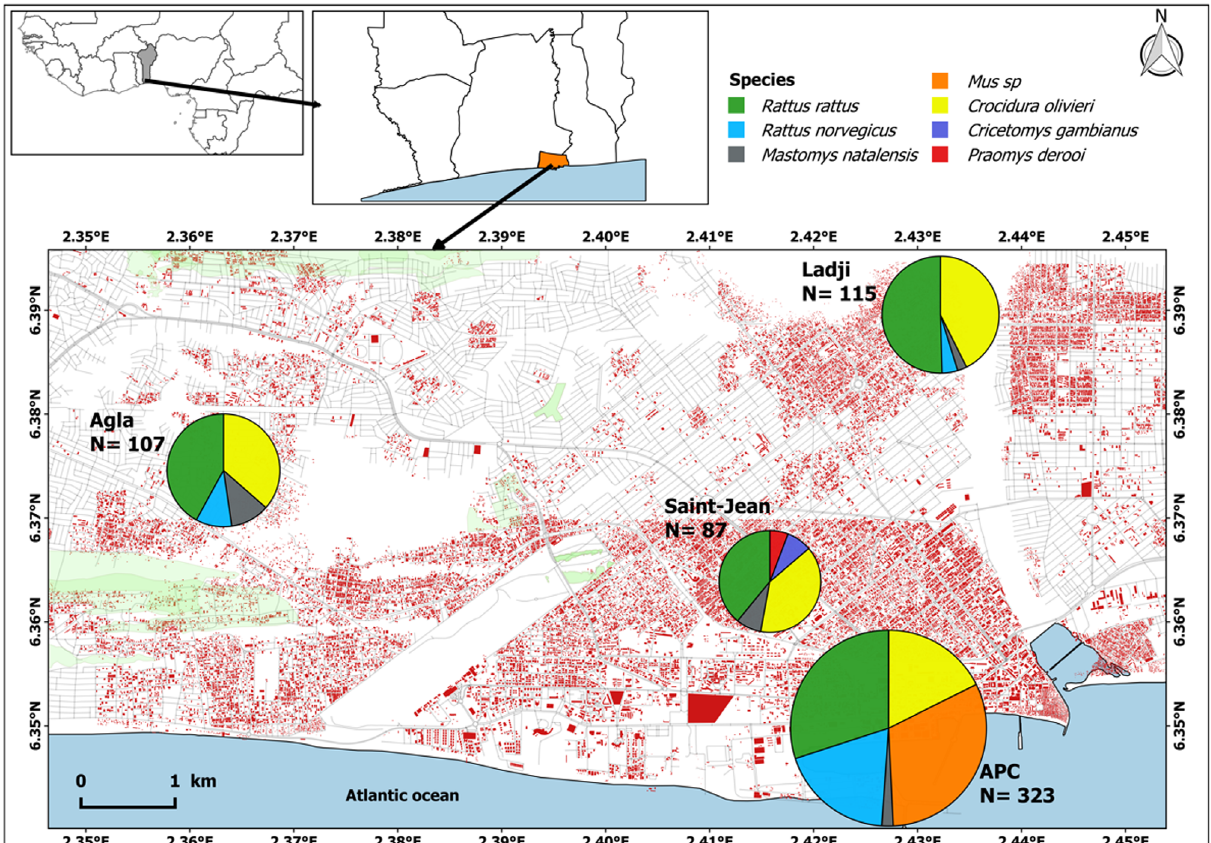
Figure 1. Distribution of sampling localities within Cotonou city, as well as micro-mammal trapping results. Circle sizes are proportional to the number of host individuals investigated for T. gondii